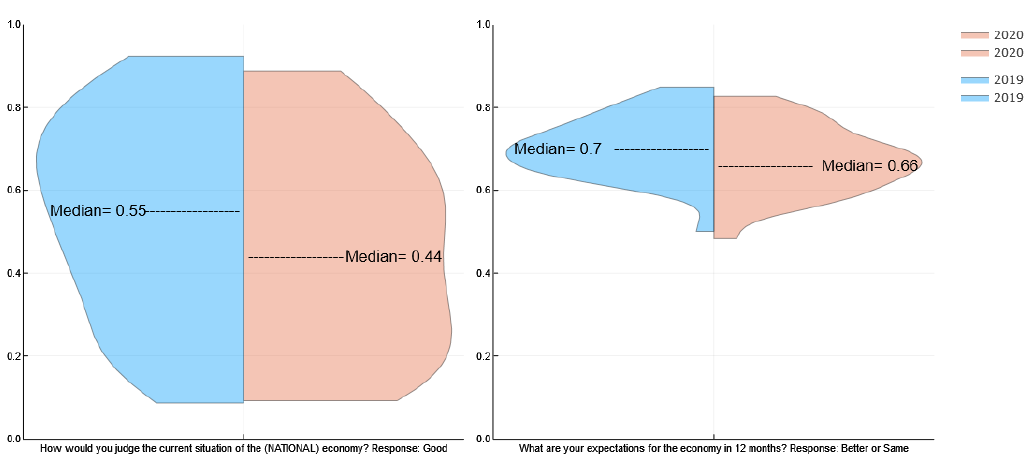
Figure 1. Peoples assessment of the economy in 2019 and 2020: In the left-hand panel, how would you judge the current economic situation. In the right-hand panel, what are your expectations for the economy in 12 months. Both panels list always the positive responses, i.e., all people responding with good, better or the same. Source: Eurobarometer-Standard